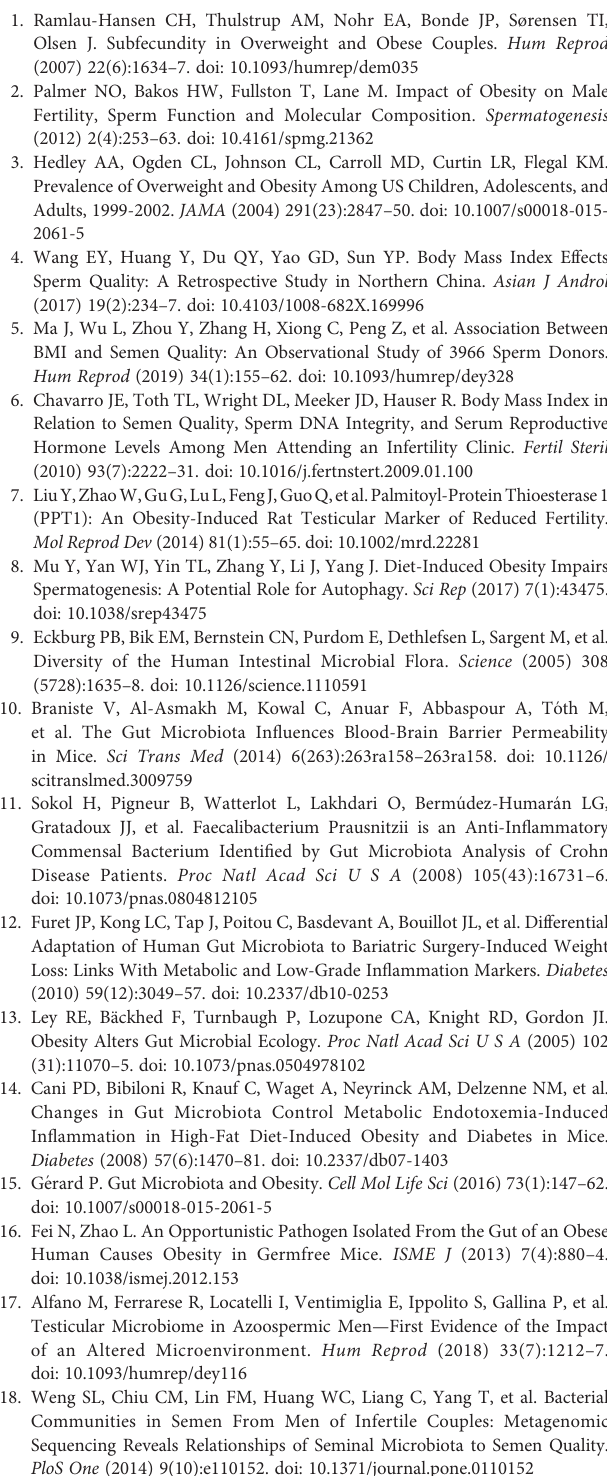
Supplementary Figure 4 | Species composition at different levels of the testicular bacterial community at the gate level and heatmap and sample cluster tree analyses.